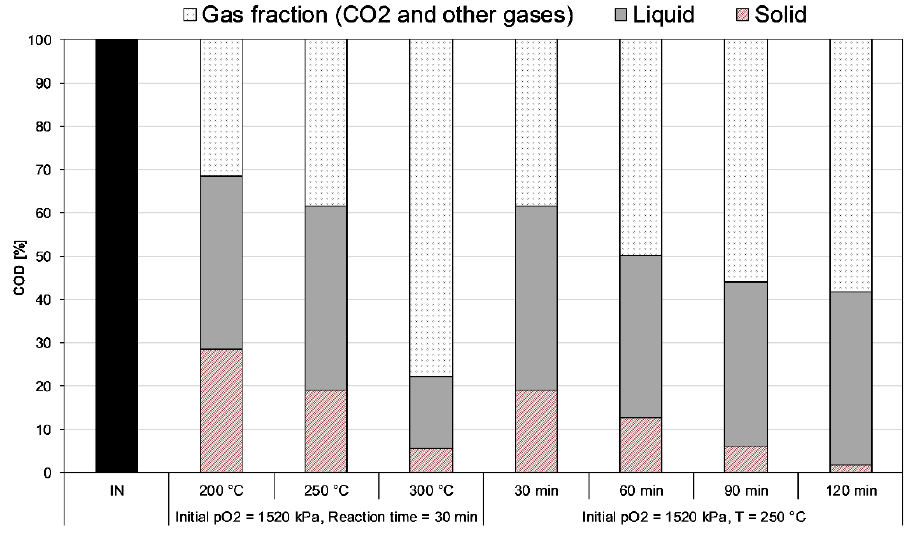
Figure 5. Results obtained for soil #1. COD balance after the WO treatment.